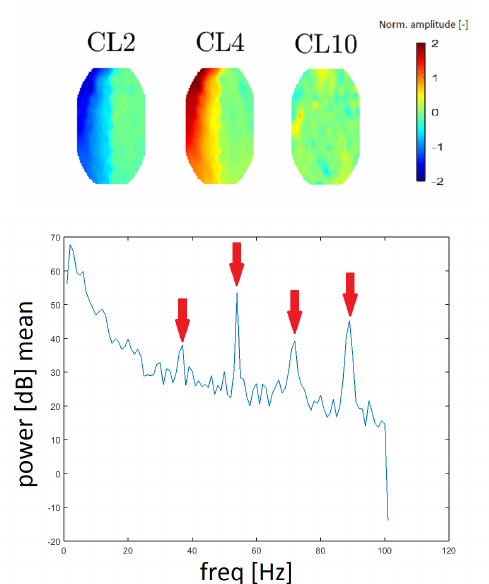
Figure 11. Topomaps of the clusters representing gradient artifact (GA) residues from magnet coil switching ( top ). The mean power spectrum of the GA found for cluster CL10 ( bottom ). Arrows show the amplitudes at 36, 54, 72, and 90 Hz (spacing of 18 Hz). The mean power spectra for clusters CL2 and CL4 are similar in